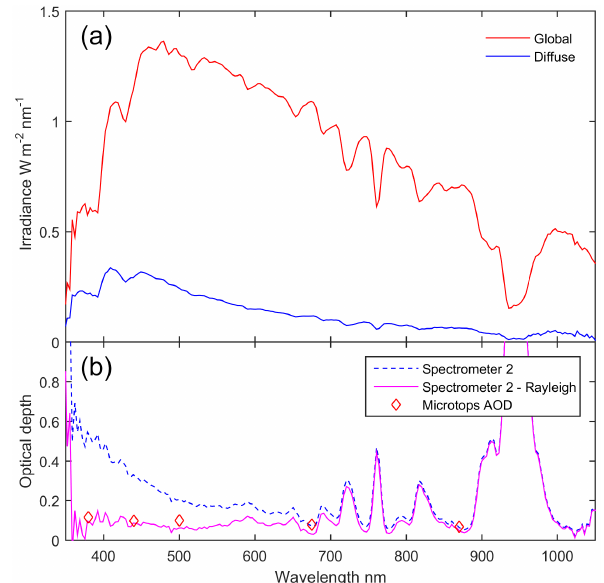
Figure 10. Time-series plots of integrated PAR values of I G and I D (a) and AOD 500nm (b) for 4 October 2014. The Microtops 500nm values are superimposed on the AOD plot. Cloud affected AOD have not been removed from the spectrometer database.